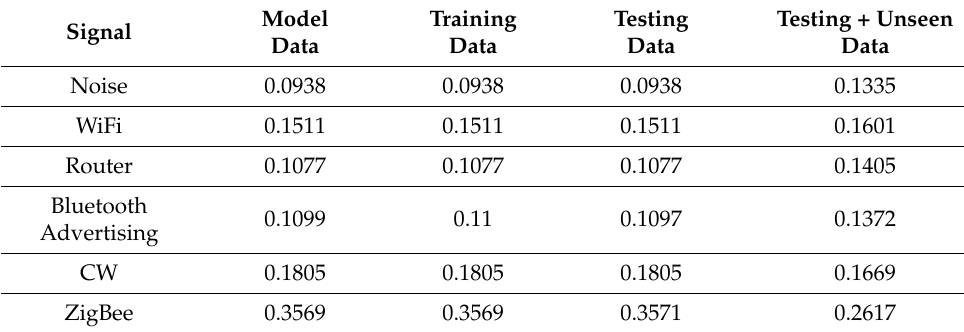
Table 4. Sampling Bias Comparison in Developed